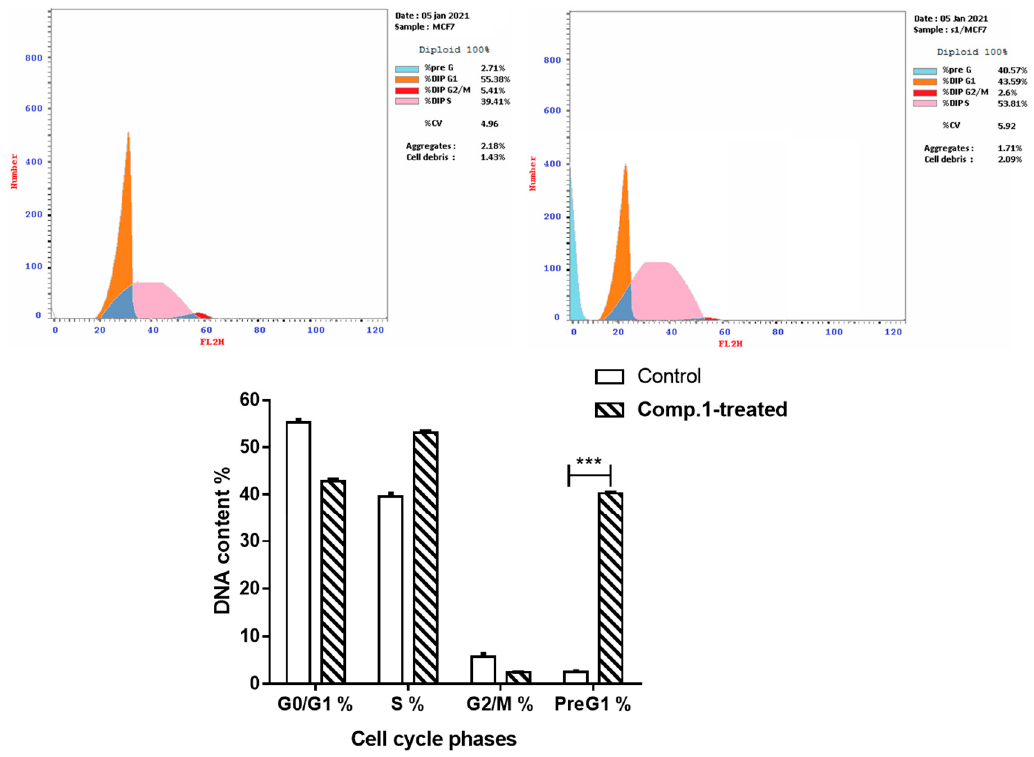
Figure 5. Histogram DNA content flow cytometry aided cell cycle analysis of untreated and compound 1 -treated MCF-7 cells (IC 50 = 4.26 µ M, 48 h), with Bar-representation of the percentage of cell population at each stage of cell cycle G0/G1, S, G2/M, and Pre G1. *** p ≤ 0.001 are significant different